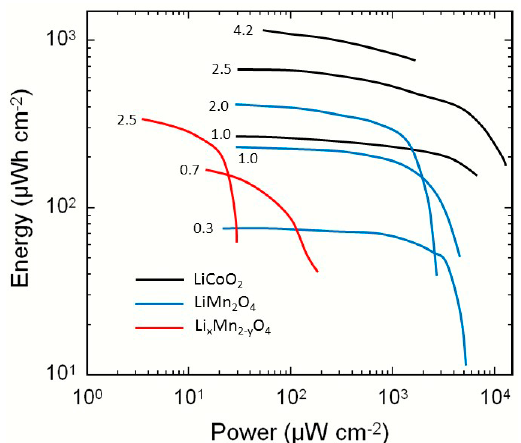
Figure 17. Ragone plot (normalized by the active cell area) for lithium thin-film microbatteries fabricated with crystalline LiCoO 2 (black lines), crystalline LiMn 2 O 4 (blue lines), and nanocrystalline Li x Mn 2 − y O 4 (red lines) cathode materials with different thicknesses (in µm).